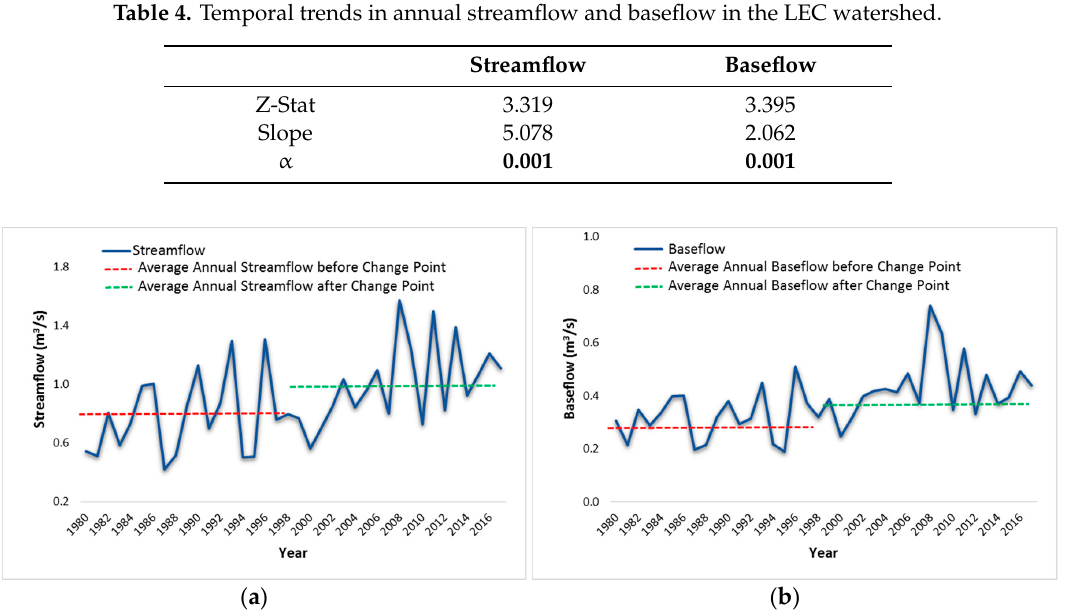
Figure 5. Average daily streamflow ( a ) and baseflow ( b ) over time in the LEC